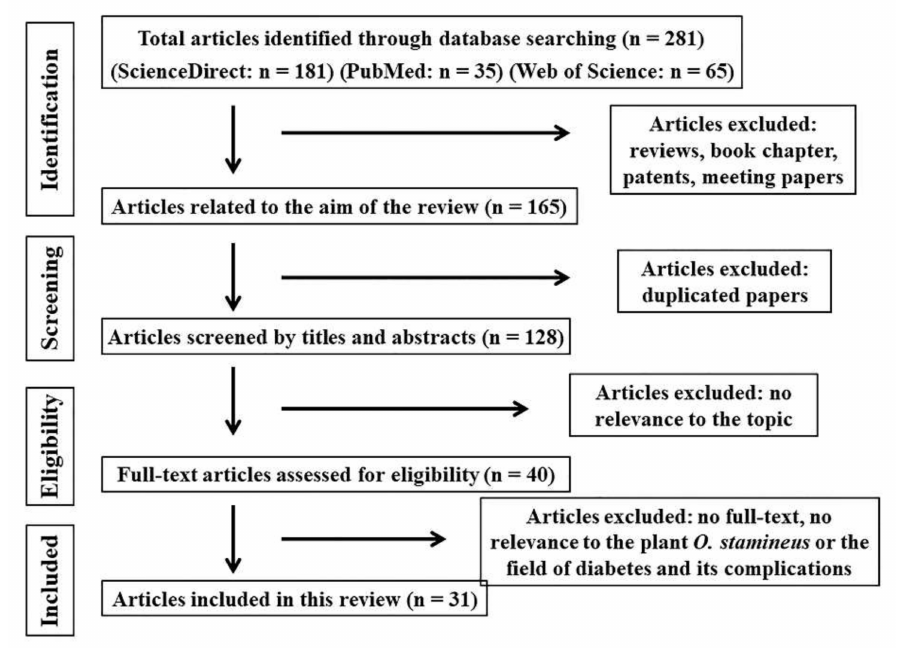
Figure 1. The flowchart of the literature search and selection process based on